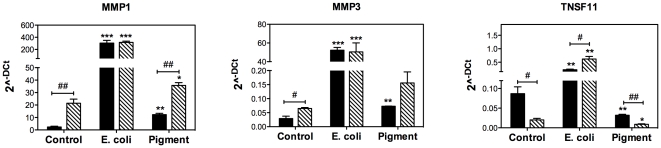
Quantitative real-time PCR confirmation of selected genes with differential expression in phagocytically challenged porcine TM cells under physiological (black bars) and oxidative stress (stripped bars) conditions.The expression levels were calculated using the formula 2−ΔCt, where ΔCt = Ctgene−Ct average housekeeping. β-Actin, GAPDH, and HPRT1 served as internal standard for normalization. Values represent mean ± SD. (*) compares phagocytically challenged versus control cultures; (#) compares oxidatively stressed versus cultures grown under physiological conditions. *, # p<0.05, **, ## p<0.005, ***, ### p<0.0005 (t-test, n = 3).